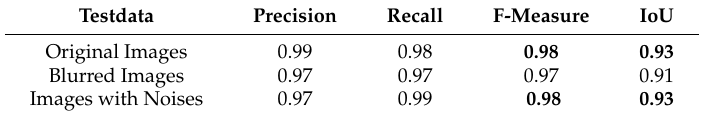
Table 4. Comparison between performance on original data and challenging